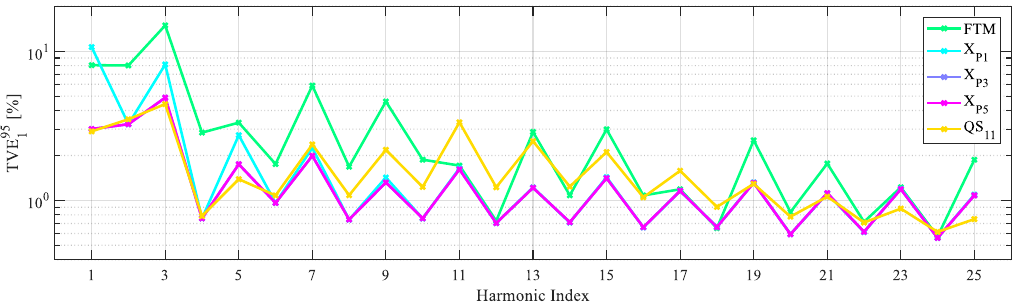
ff erent behavioral